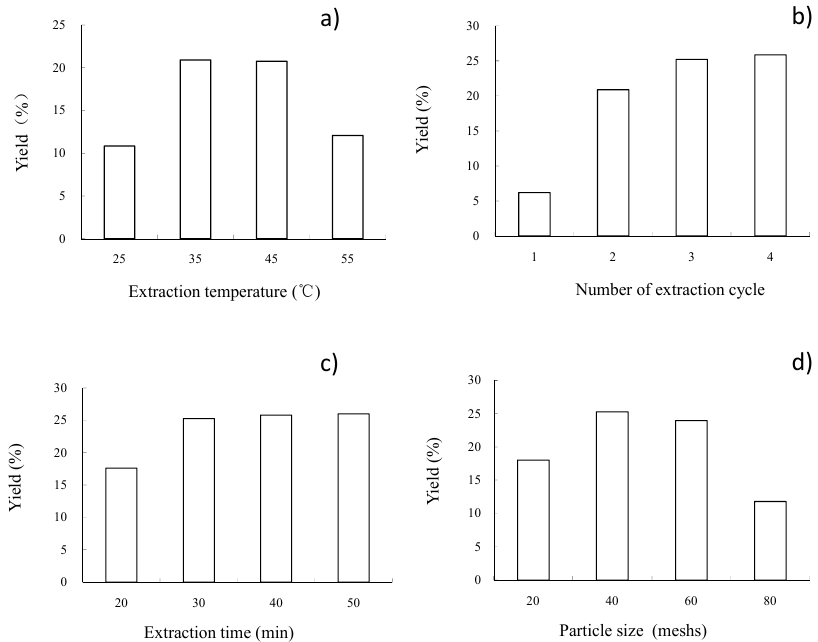
Figure 1. Effects of ( a ) extraction temperature; ( b ) number of extraction cycles; ( c ) extraction time; ( d ) sieve mesh on the yield of C. sinensis seed oil extracted using subcritical fluid extraction (SbFE).